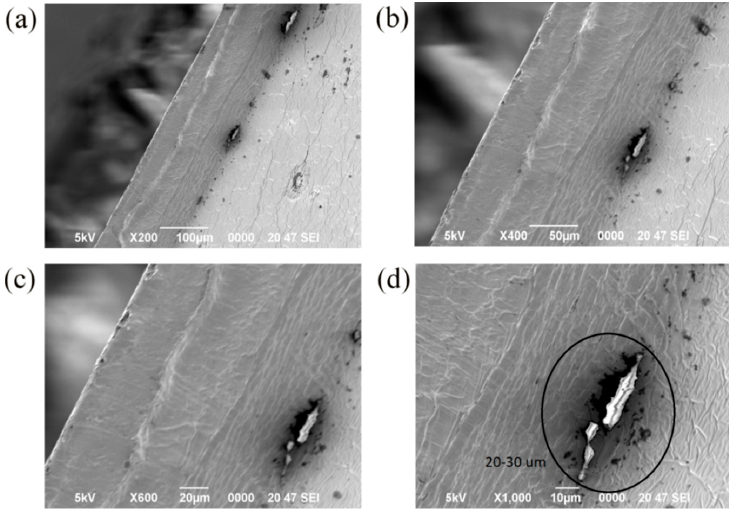
Figure 9. SEM images of 1%S monolayer with different magnifications: ( a ) 200×; ( b ) 400×; ( c ) 600×; and ( d ) 1000×.